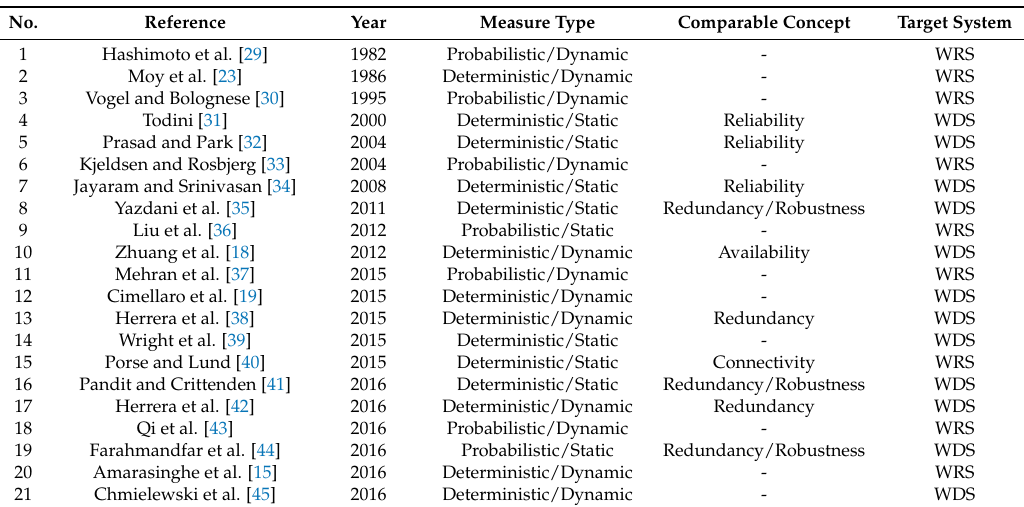
Table 1. Listing of measures selected for